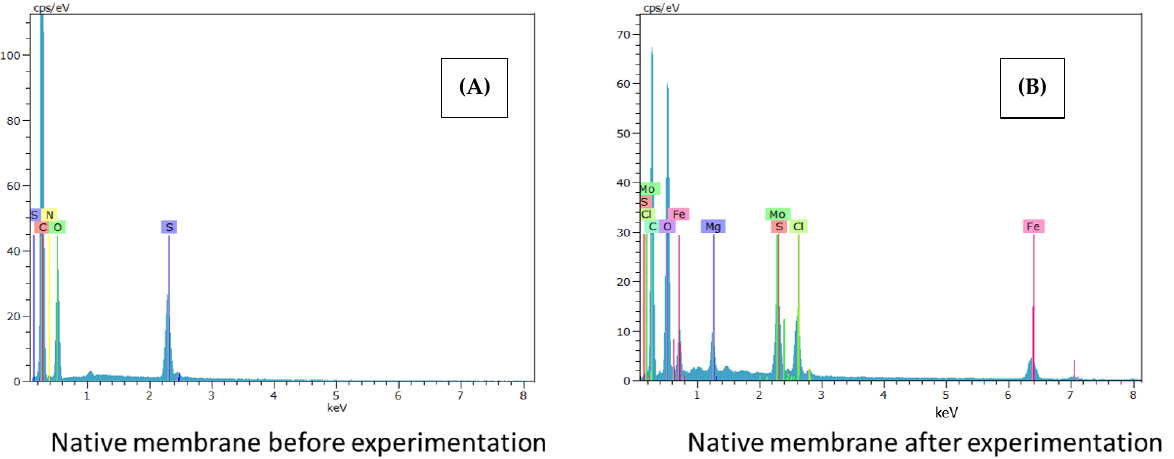
Figure 2. SEM-EDX spectra obtained with ( A ) the native membrane before and ( B ) after the experi- ments.